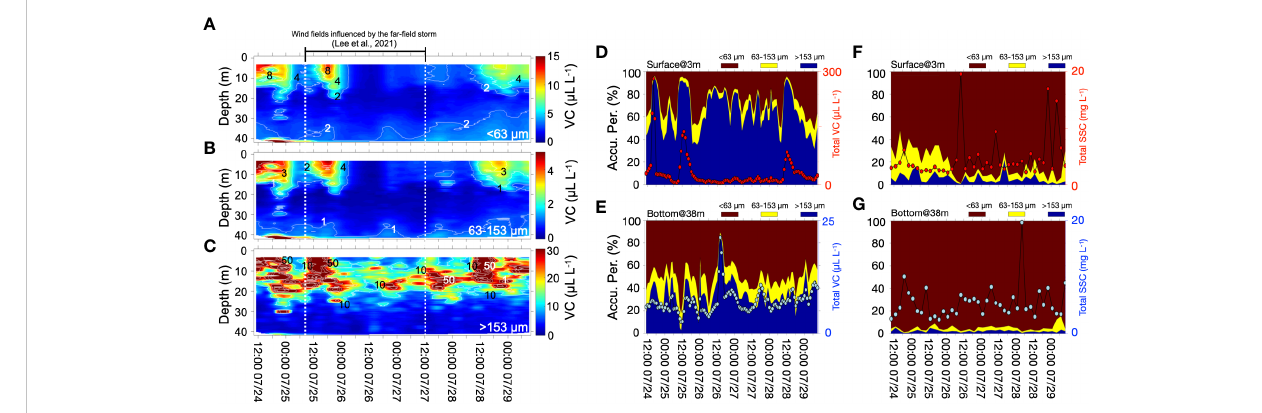
FIGURE 5 Temporal changes of the 2-D structure of the volume concentration (VC) of the size of (A) <63, (B) 63-153, and (C) >153 µm. The white dash lines in (A-C) mark the duration of the storm in fl uence. Temporal variabilities of the accumulative percentages of size compositions of VC and SSC at the surface (D, F) and the bottom (E, G) . The color codes above each frame indicate different size classes.